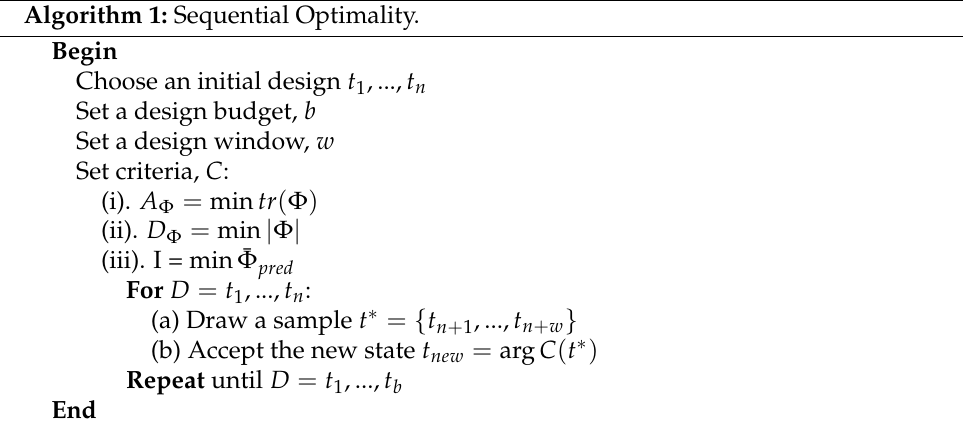
Algorithm 1: Sequential